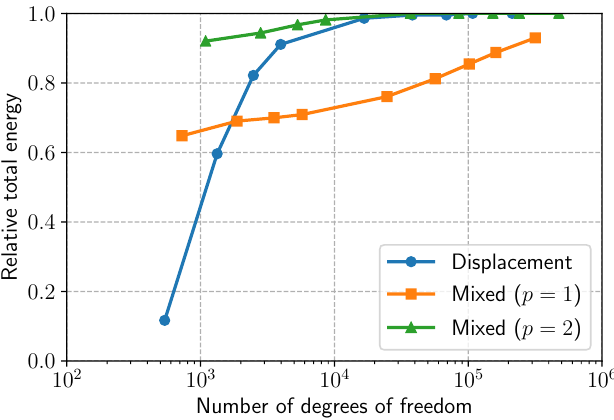
Figure 4. Total energy convergence for the clamped thin plate case.